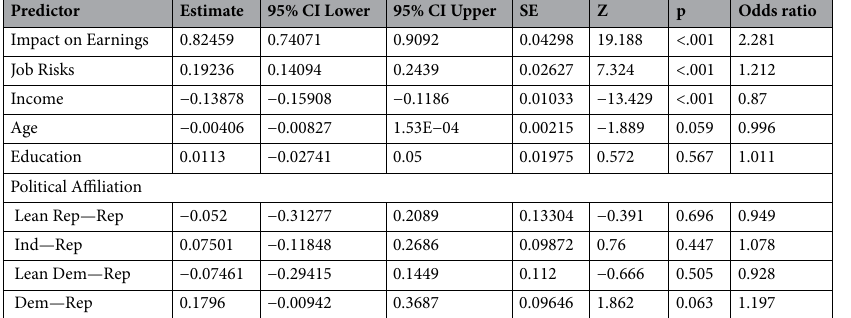
Table 1. Model coefficients for ordinal logistic regression predicting feelings of financial